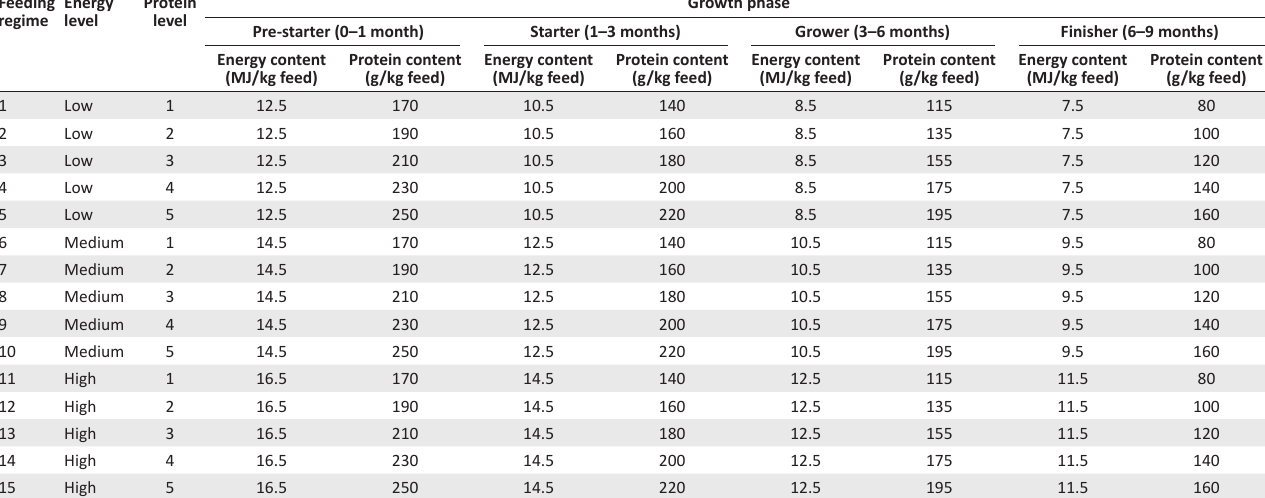
TABLE 1: Energy and protein contents (as is) of treatment diets used during the separate growth phases of ostriches. Feeding Energy Protein regime level level